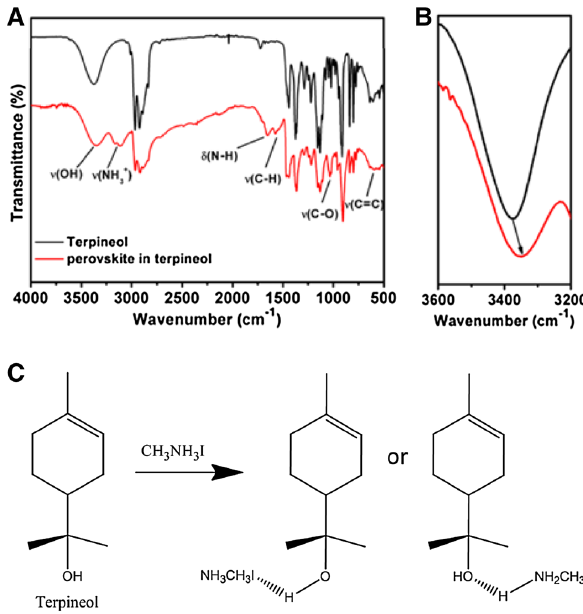
Fig. 8 Fourier transform-infrared spectra (FT-IR) of a pure terpineol and perovskite film made from the perovskite paste, b expanded fingerprint region for the O–H vibrations, and c schematic of possible interactions between MAI and terpineol along with their chemical structures